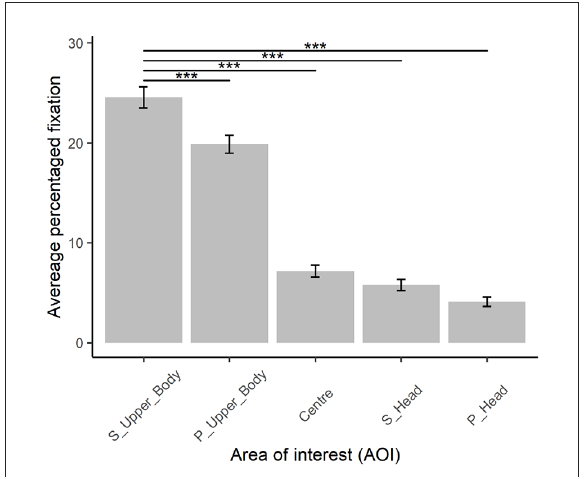
FIGURE7 Distribution of visual attention across different areas of interest (AOI): S_Upper_Body (upper body of the Secondo), P_Upper_Body (upper body of the Primo), center of the screen, S_Head (head of the Secondo) and P_Head (head of the Primo). Error bars represent 95% CI of the mean. ∗∗∗ p <